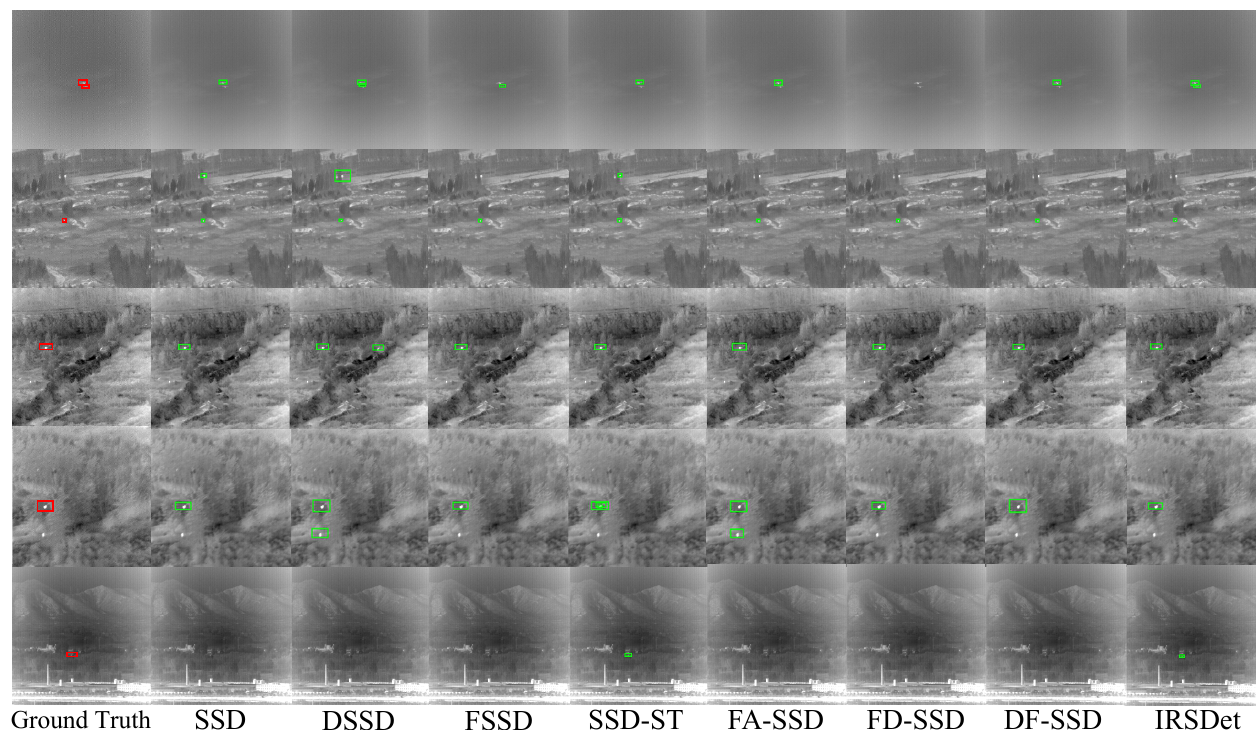
Figure 11. Detection results of advanced detection